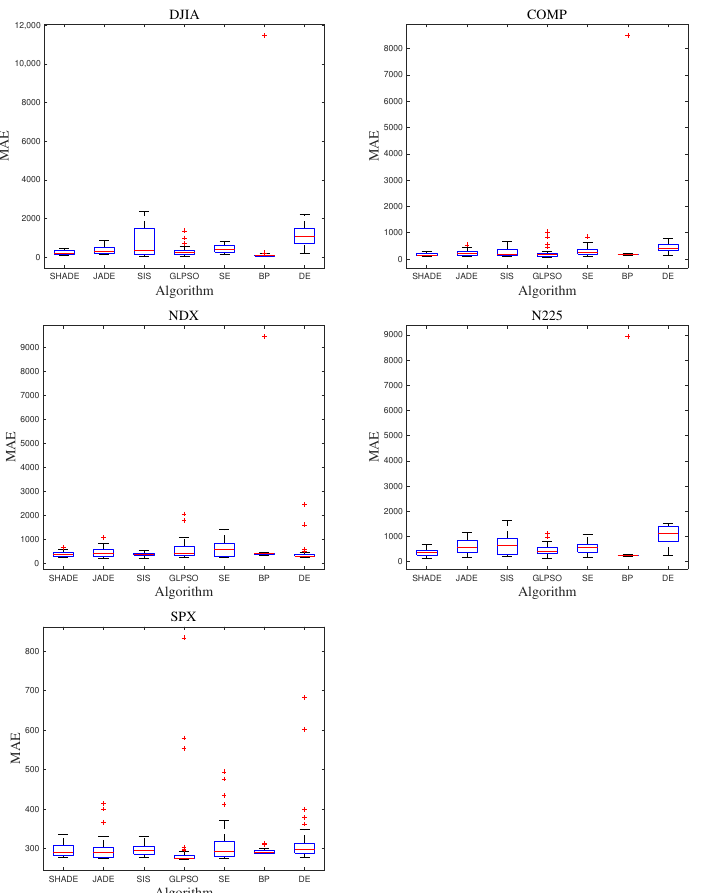
Figure 5. MAE plots of six MHAs and BP-trained DNMs on DJIA, COMP, NDX, N225, and SPX.